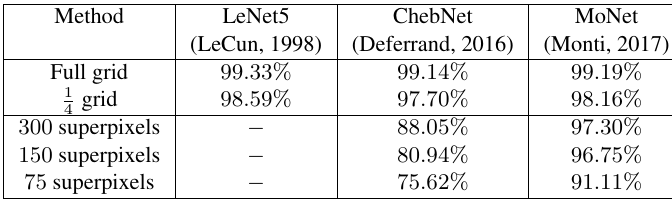
Table 1. Classification performance for various input formats